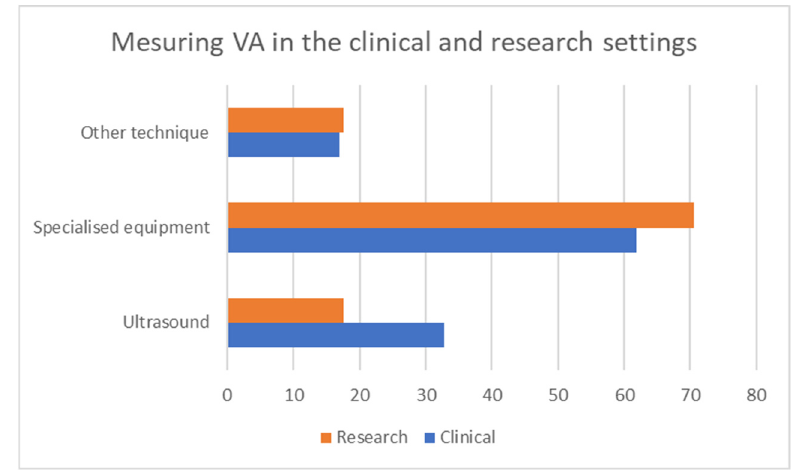
Figure 4. Categories of responses on measuring VA by setting .